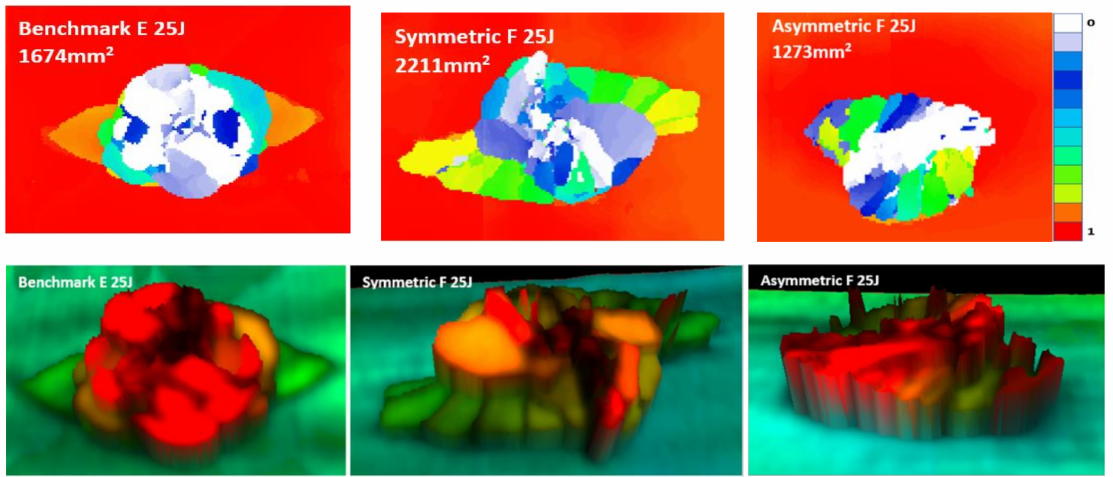
Figure 14. Time-of-flight C-scans and 3D images of the 25 J impact samples for the benchmark, symmetric (FGPS) and asymmetric (FGPA) configuration.